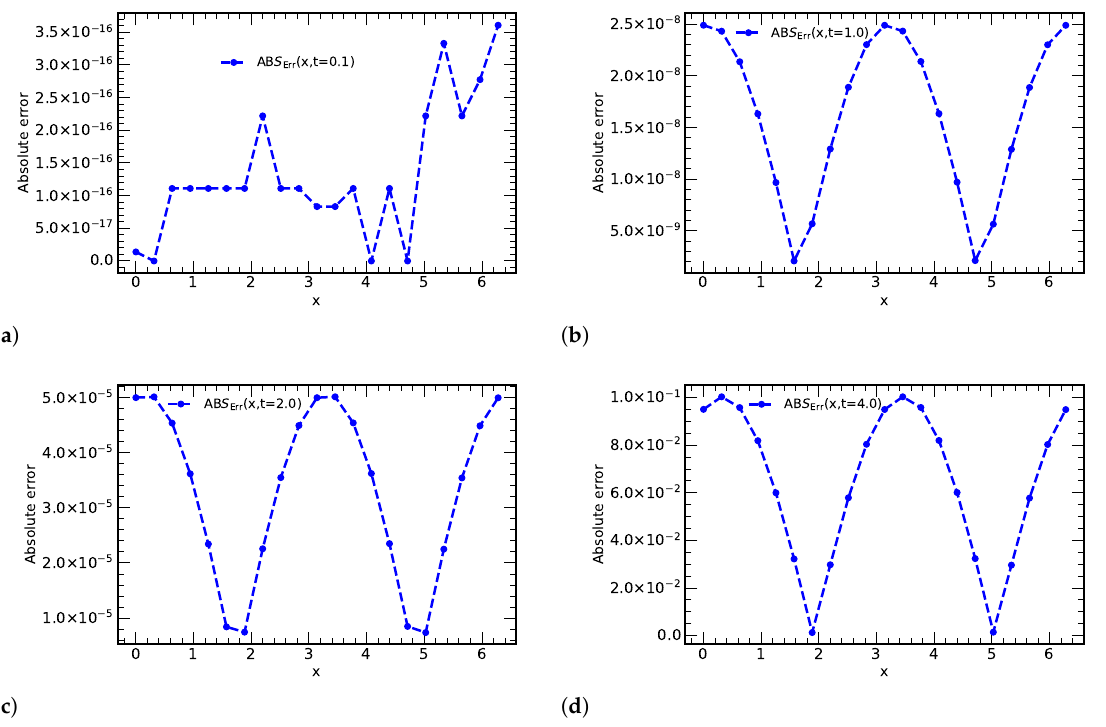
Figure 2. Plots of absolute errors vs. x at some values of time; t = ( a ) 0.1, ( b ) 1.0, ( c ) 2.0, ( d ) 4.0 using n = 10 terms from VHPM